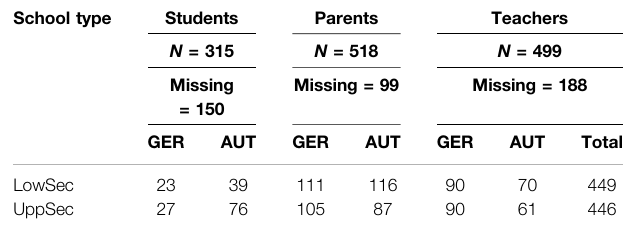
TABLE 1 | Sample by country and school type.